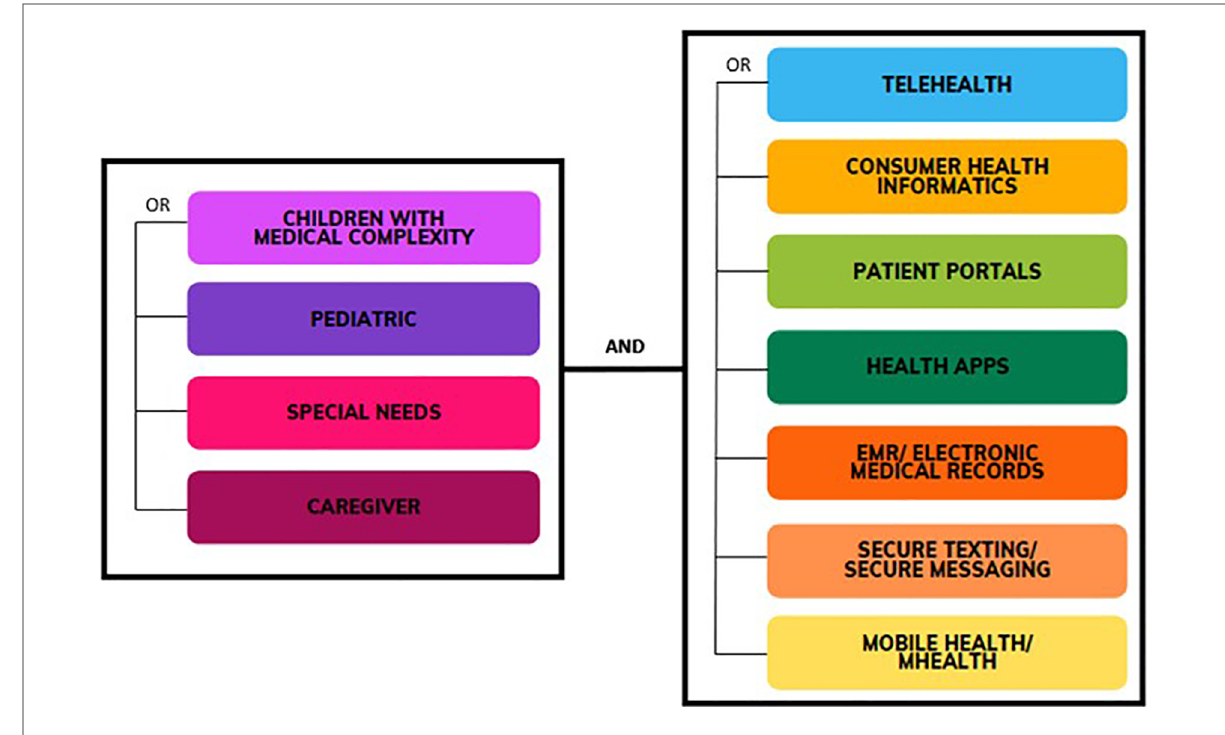
FIGURE 1 Mesh terms used in this systematic mapping review.